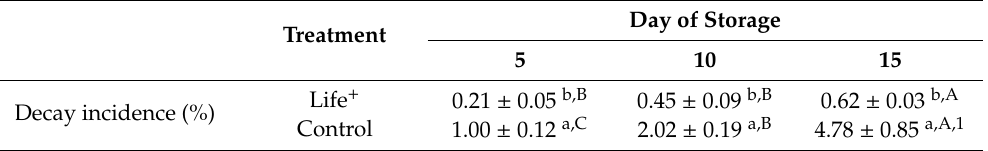
Table 7. Decay incidence (%) in sweet cherries stored at 6 ◦ C after 5 to 15